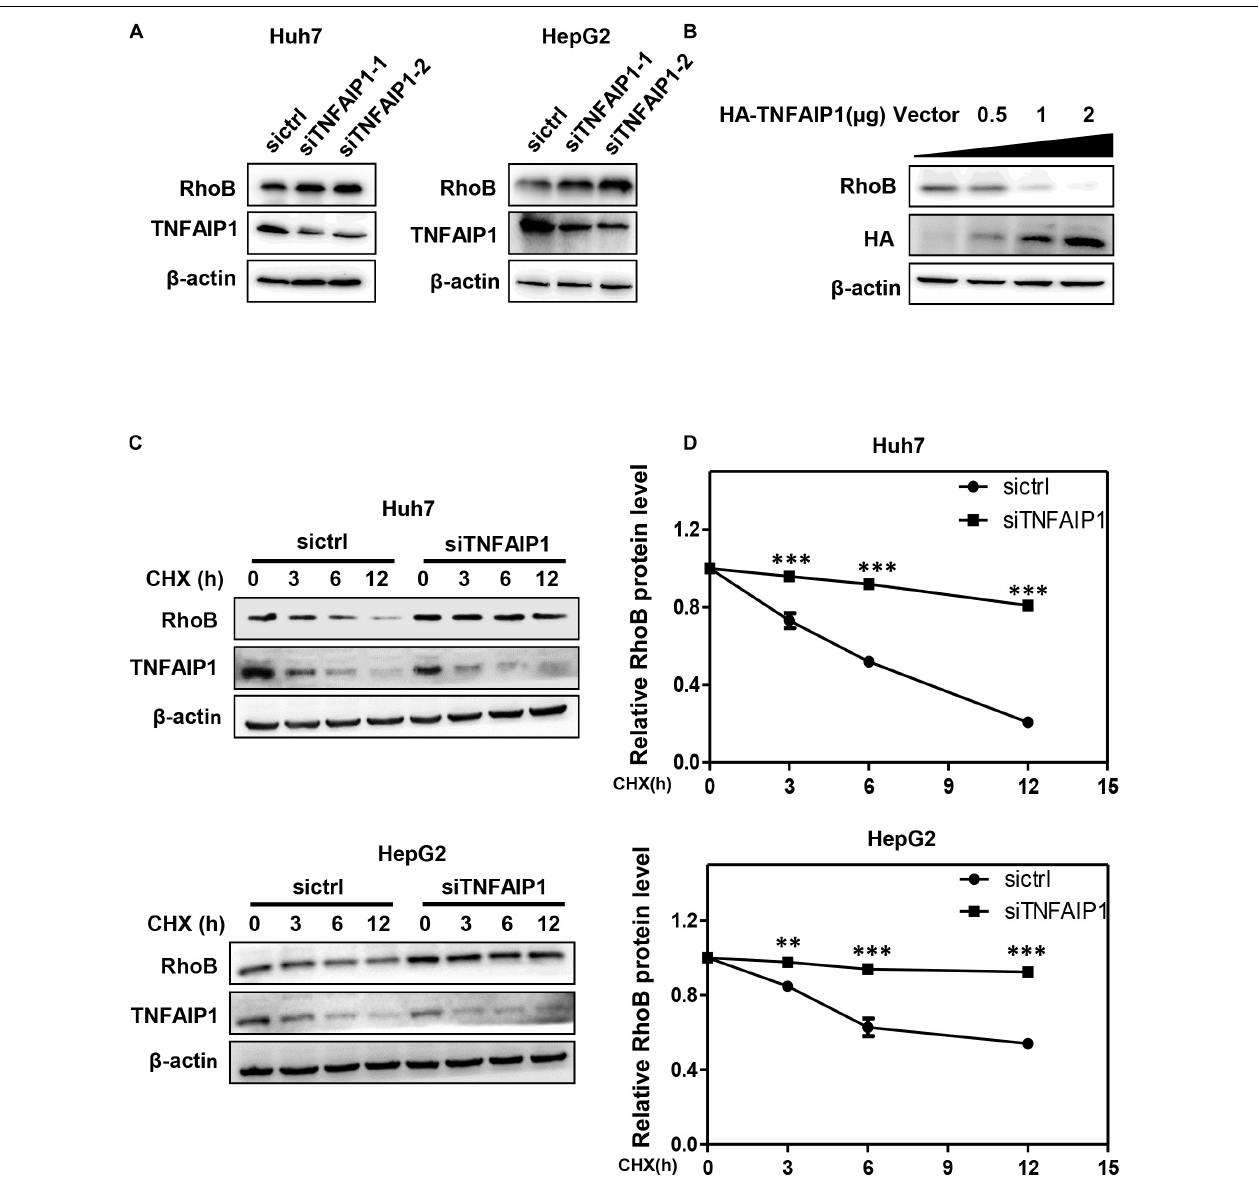
FIGURE 2 | The BTB domain protein TNFAIP1 regulated RhoB degradation. (A) Knockdown of TNFAIP1 led to RhoB accumulation in both Huh7 and HepG2 cells. Cells were transfected with ctrl (control), TNFAIP1-1 or TNFAIP1-2 siRNA for 96 h, and cell lysates were harvested for western blot analysis. (B) Overexpression of TNFAIP1 down-regulated the protein levels of endogenous RhoB. HEK293T cells were transfected with indicated concentration of HA-TNFAIP1 plasmid or empty vector, and cell lysates were harvested for western blot analysis. (C) Ablation of TNFAIP1 prolonged the half-life of RhoB. Huh7 and HepG2 cells were transfected with indicated siRNAs for 96 h. After 50 µ g/mL cycloheximide (CHX) treatment at the indicated time, cell lysates were harvested for western blot analysis. (D) The protein levels were quantified by densitometric analysis and statistical analysis was performed. ∗∗ P < 0.01 and ∗∗∗ P < 0.001 vs. control